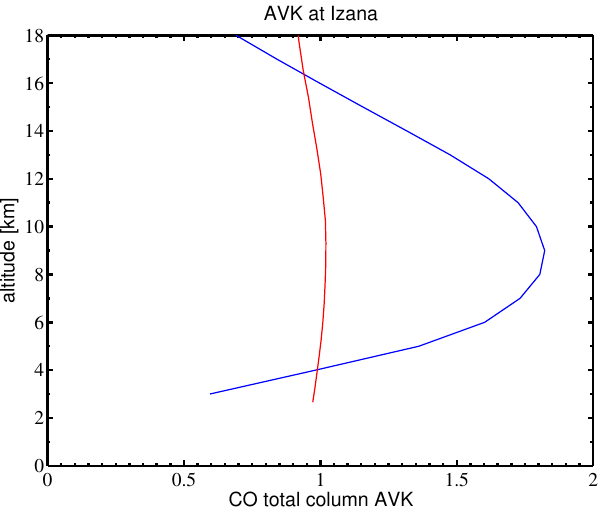
Fig. 3. Mean ground-based FTIR averaging kernels (red) compared to the mean IASI averaging kernel (blue) for Iza˜na. The averaging kernels are shown for altitudes above the station (2367m).